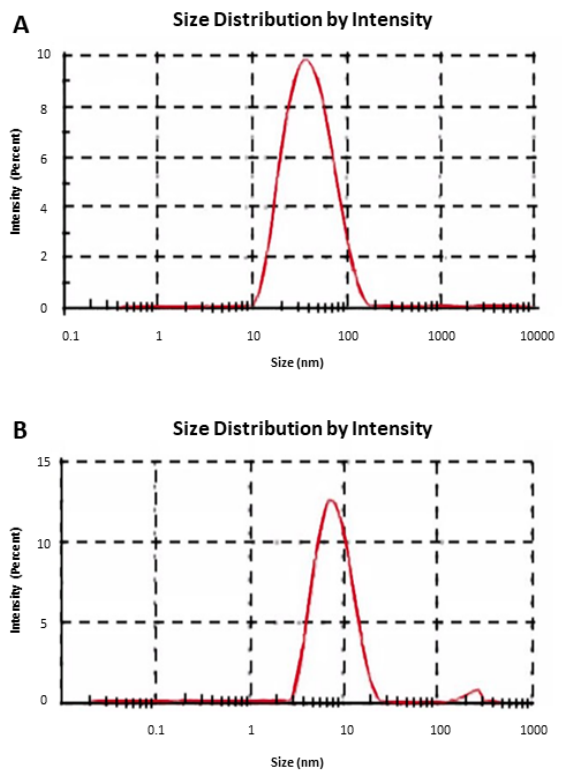
Figure 2. Particle size distribution of synthesized ( A ) silver nanoparticles (32.16 nm) and PDI (0.2), and ( B ) silver chitosan nanoparticles (50 nm) and PDI (0.2).